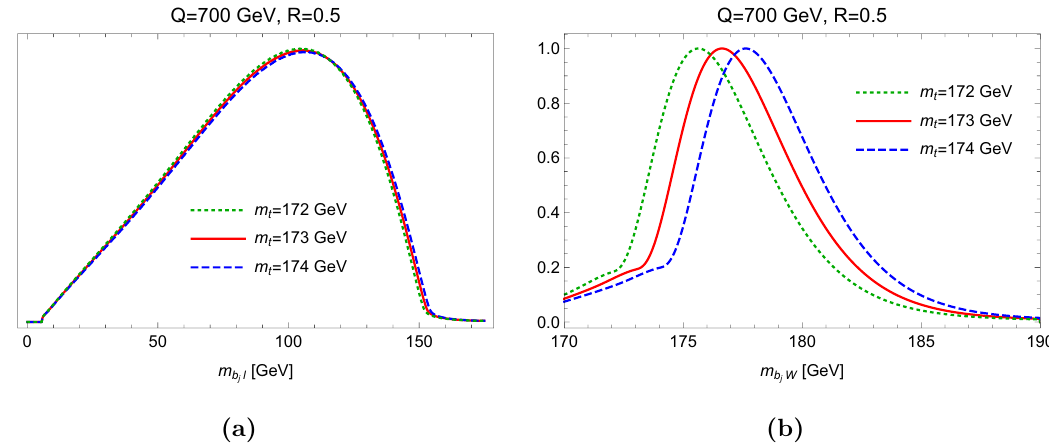
Figure 15. The m b (left panel) and m b distributions (right panel) generated by Herwig 7 j ‘ j W for top masses between m t = 172 (dotted green), 173 (solid red) m t = 174 GeV (dashed blue) for Q = 700 GeV, jet radius R = 0 : 5 and Cambridge-Aachen-type b -jet clustering.